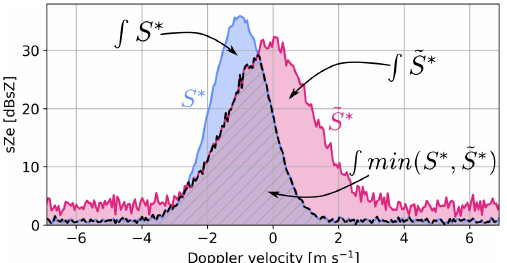
Figure D1. Illustration of the overlap metric. The spectra were cre- ated for illustration purposes and are not part of the